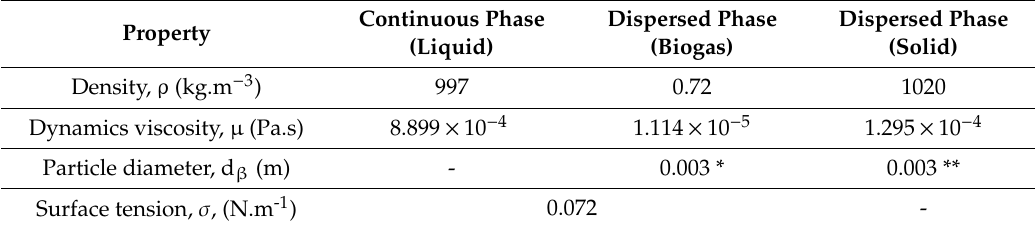
Table 2. Physical properties of the phases.